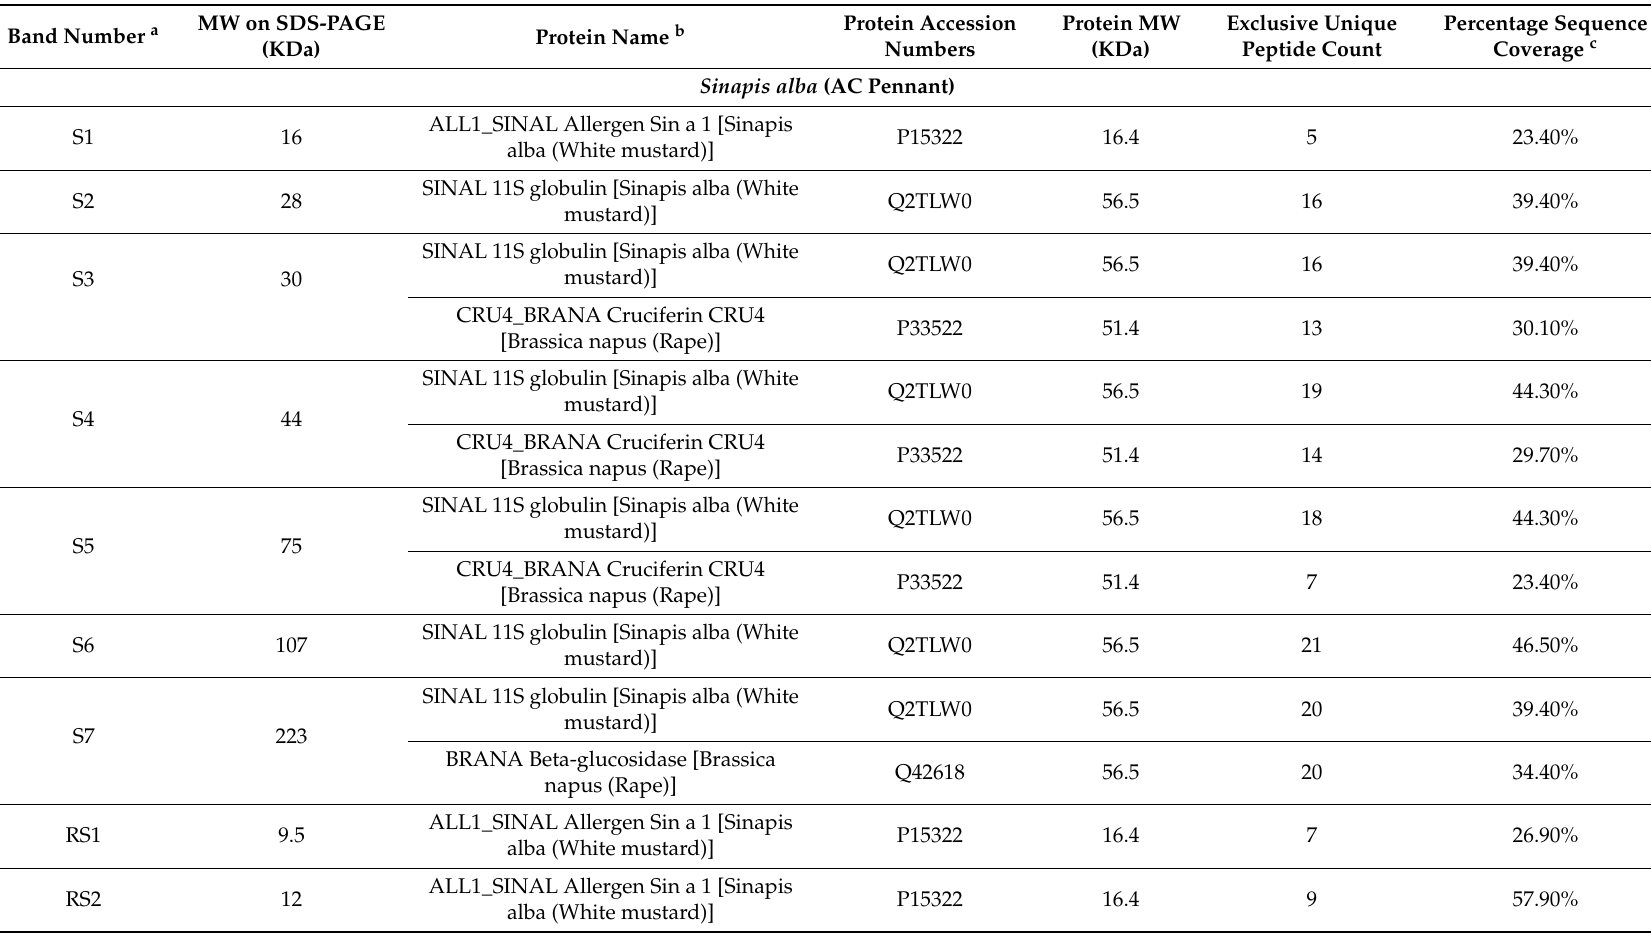
Table 2. Identification of IgE-binding proteins from Sinapis alba and Brassicae juncea mustard by mass spectrometry